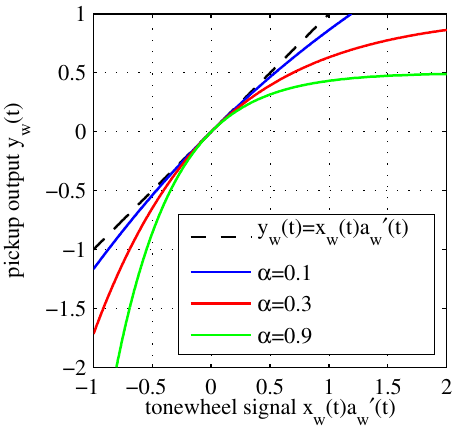
Figure 7. Memoryless tonewheel pickup